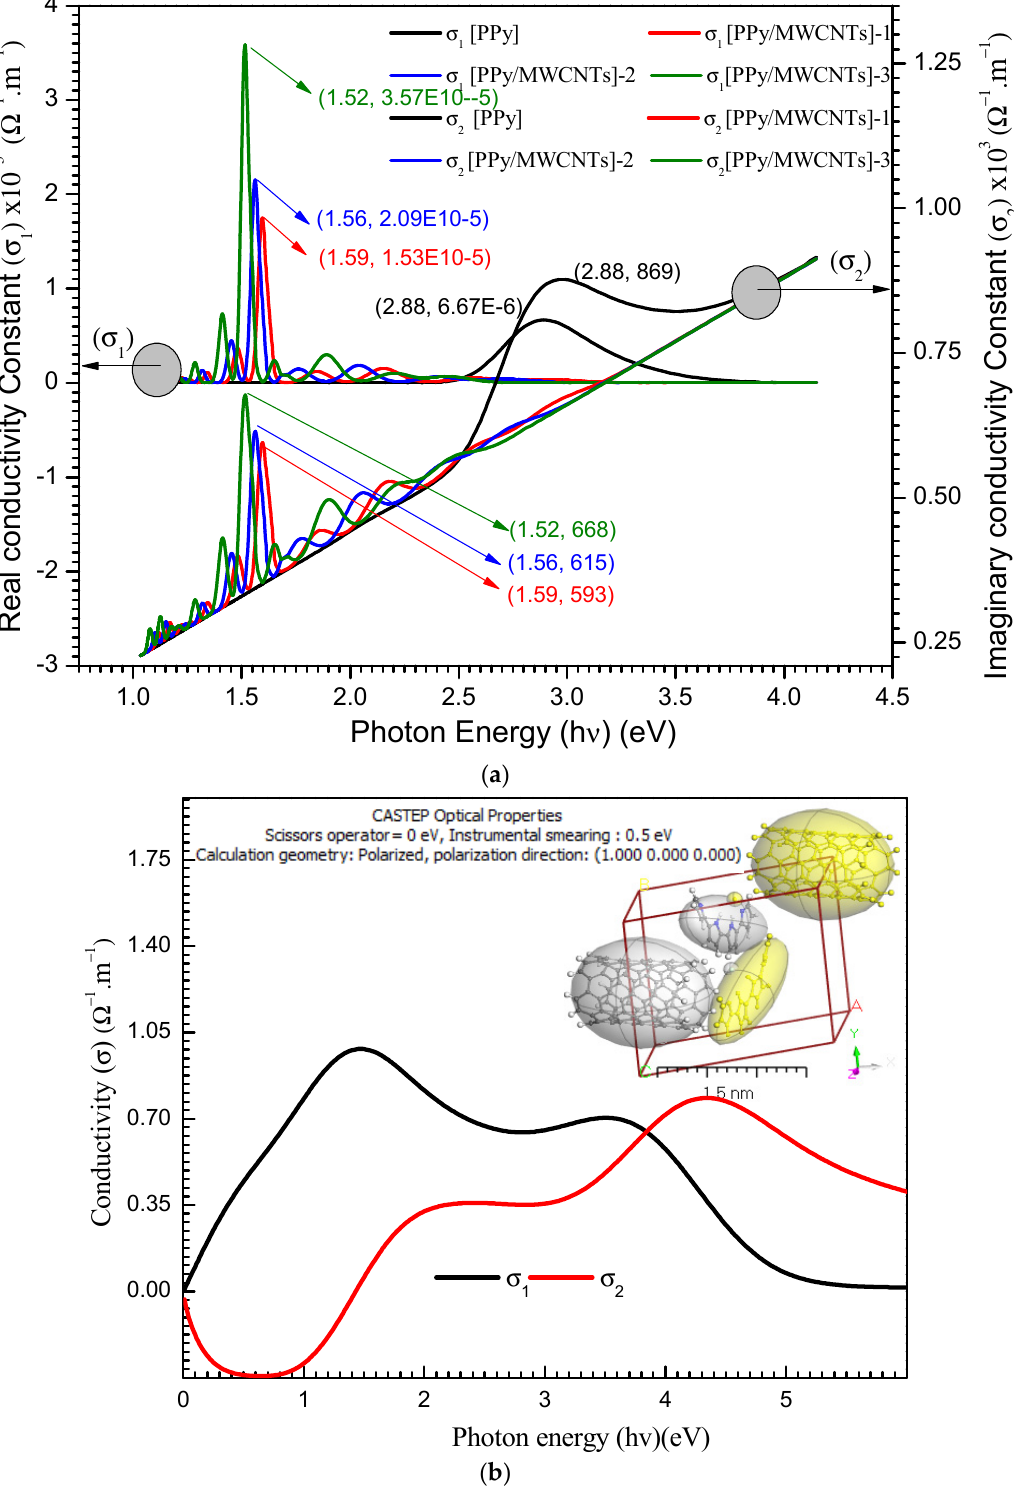
Figure 9. ( a ) σ 1 & σ 2 with (h ν ) eV for PPy and different types for PPy/MWCNTs composites thin films. ( b ) Simulation conductivity function for PPy/MWCNTs composites as isolated state by using CASTEP method. For PPy/MWCNTs composites, in the experimental part (Figure 9a), the σ 1 ( λ ) show the maximum values of 6.67 × 10 − 6 , 1.53 × 10 − 5 , 2.09 × 10 − 5 , and 3.57 × 10 − 5 for PPy/MWCNTs composites at the photon energy values of 1.52, 1.56, 1.59 and 2.88 eV,